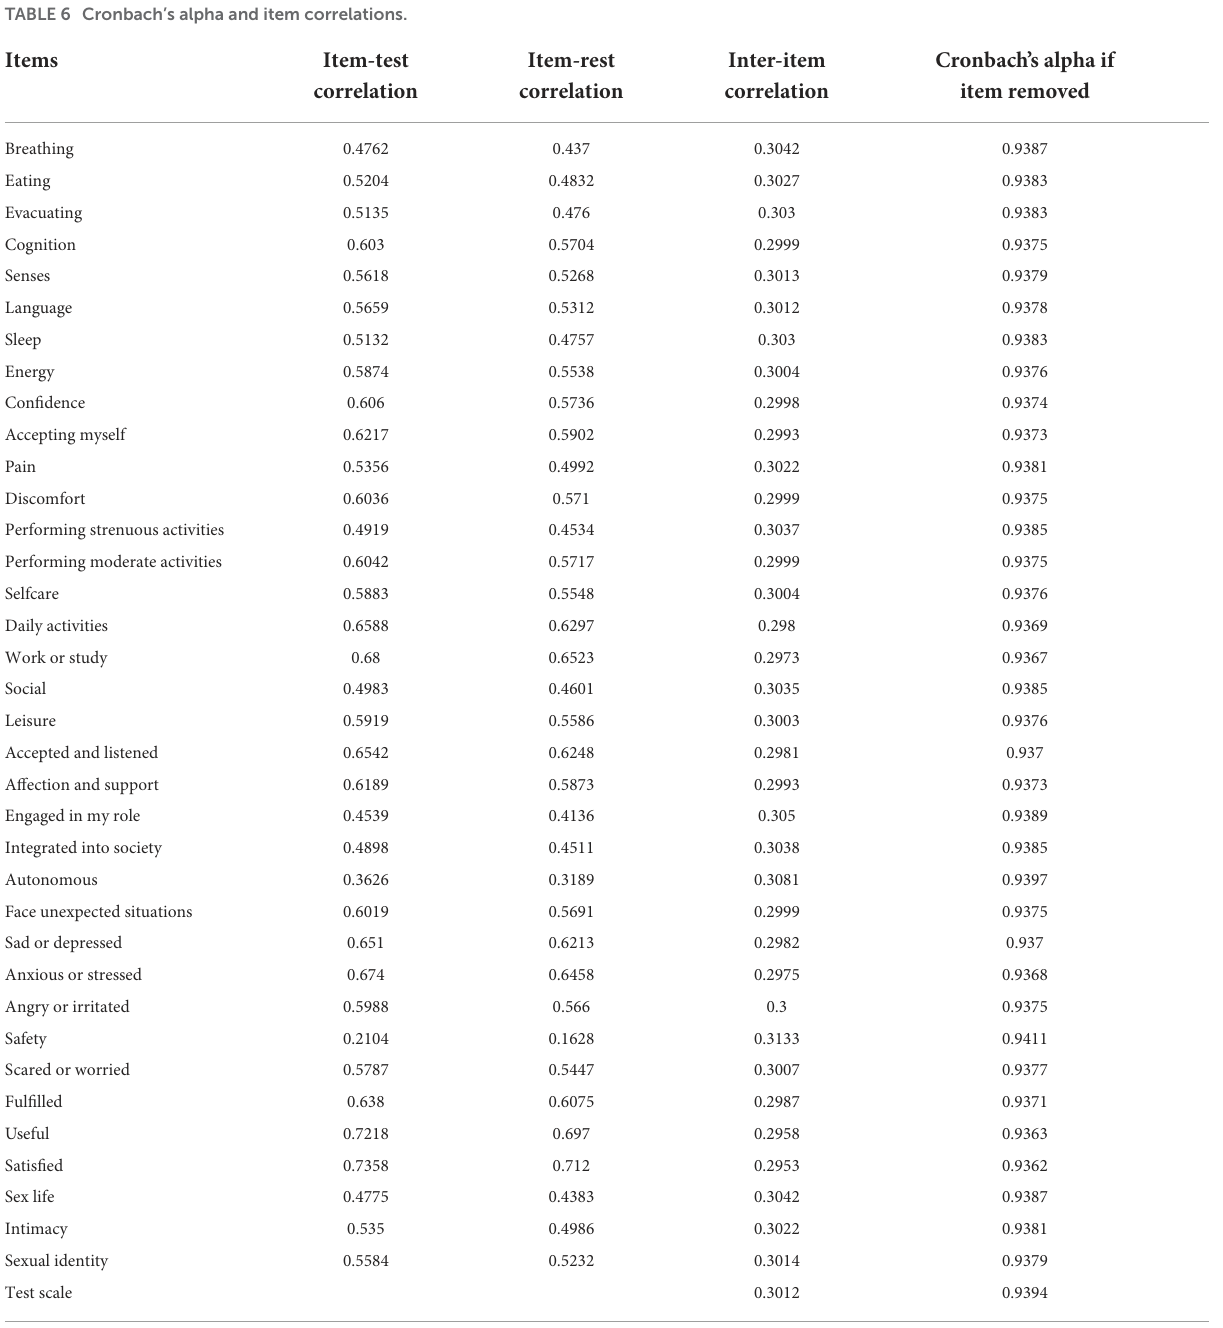
TABLE 6 Cronbach’s alpha and item